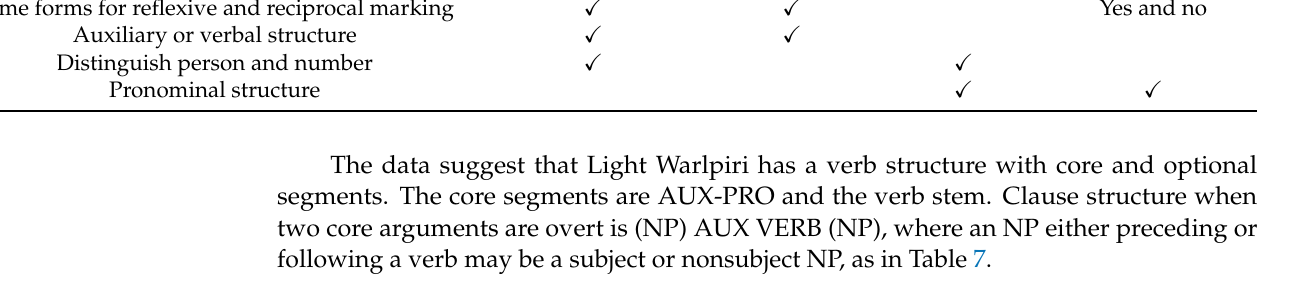
Table 7. Clause structure of Light Warlpiri.